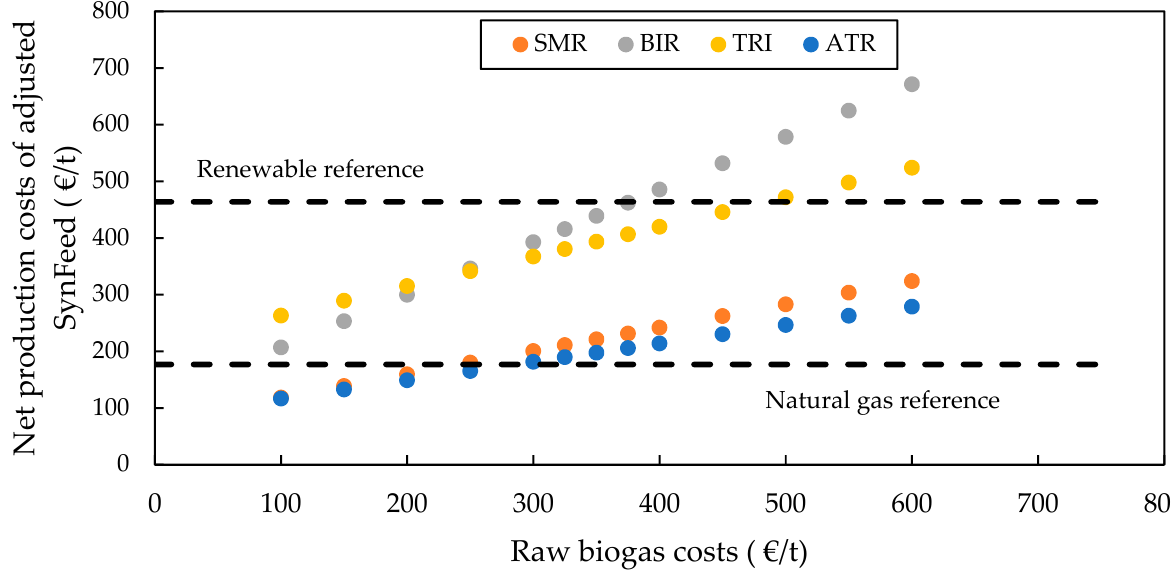
Figure 11. Net production costs of adjusted SynFeed for different raw biogas costs for mixing conditions.